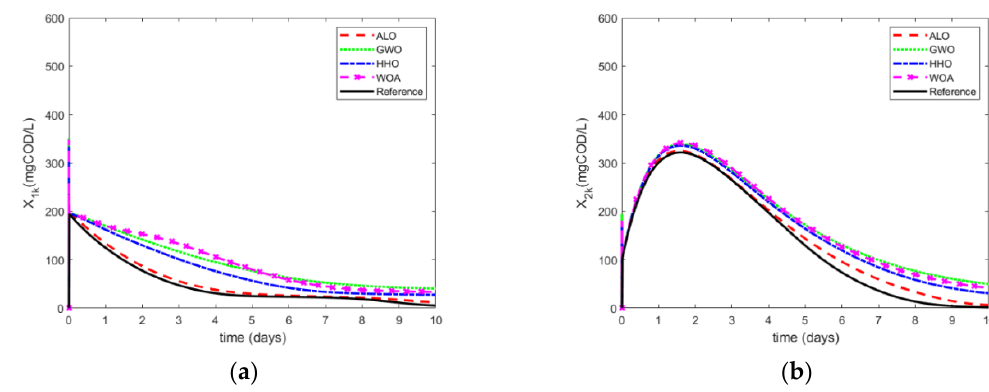
Figure 7. Tracking performance comparison in presence of external disturbance: ( a ) X 1, k and ( b ) X 2, k .